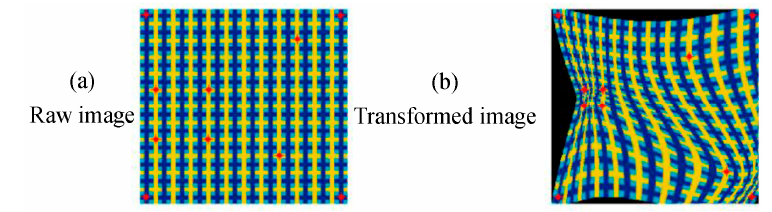
Figure 7. Image transformation using thin plate spline (TPS). The red dot in the figure is the reference point. ( a ) raw image; ( b ) transformed image.